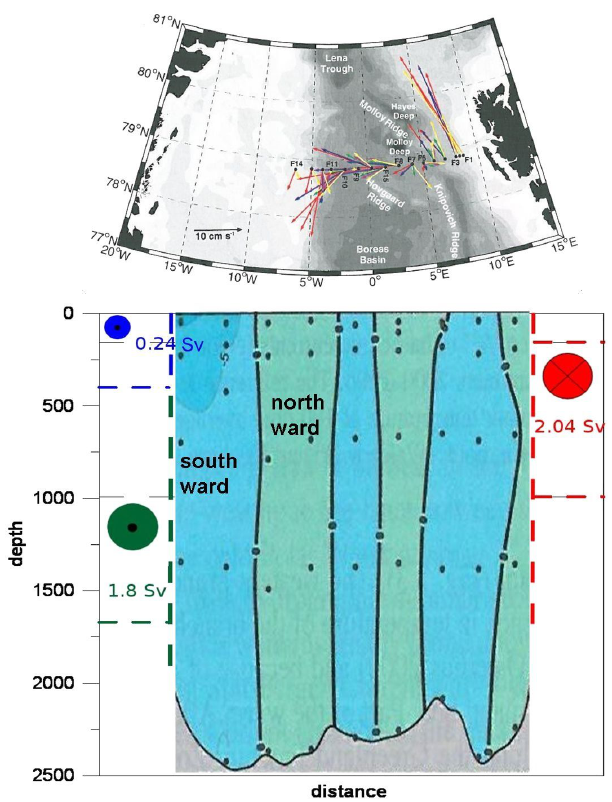
Fig. 23. The idealised transports in the boundary current shown together with the observed barotropic eddies and the recirculation occurring in the central part of Fram Strait (from Schauer et al., 2008). Here the situation with 75% of the upper layer water trans- formed on the shelves to dense shelf water and an entrainment of 60% is shown. Does such idealised two-ways picture contribute to our understanding in view of the energetic exchanges occurring in the central part of Fram Strait?